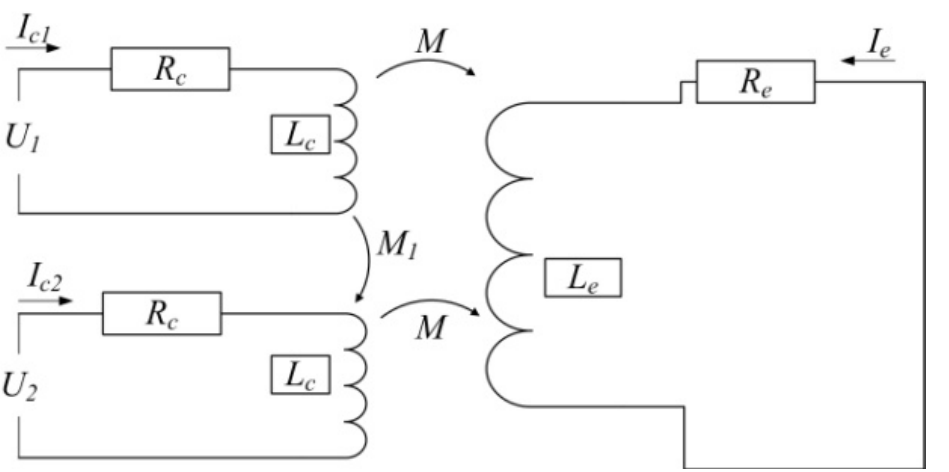
Figure 7. The equivalent circuit of the dual-coil probe and the measuring